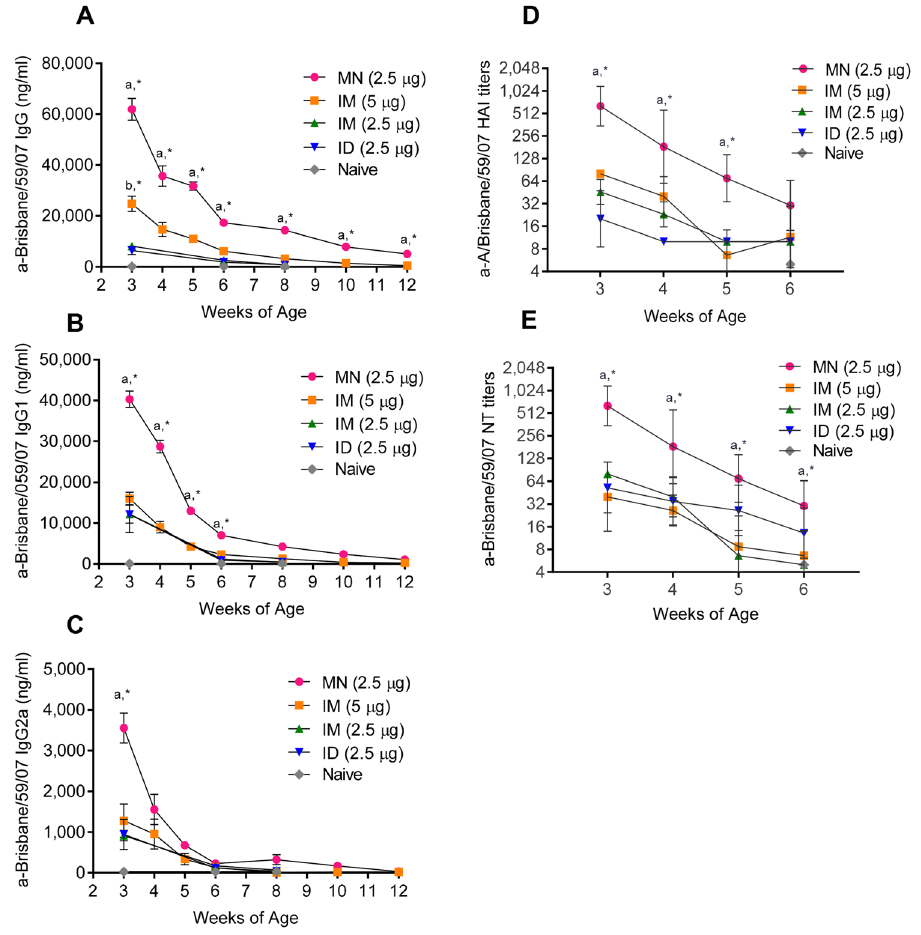
Figure 4. Humoral immune responses in pups born to mothers immunized during pregnancy. Anti-influenza binding antibodies were determined by ELISA in sera collected from pups at weeks 3 to 12 after birth. ( A ) IgG, ( B ) IgG1 and ( C ) IgG2a antibody titers [MN (2.5 ug), n = 10; IM (5 µ g), n = 10; IM (2.5 µ g), n = 5; ID (2.5 µ g), n = 5; Naïve, n = 5]. Values are expressed as mean ± SEM. ( D ) Hemagglutination inhibition (HAI) and ( E ) neutralizing antibody (NT) titers in sera collected 3, 4, 5, and 6 weeks after birth (n = 5 per group). HAI and NT values are expressed as geometric mean with ± 95% confidence interval. a [MN vs IM (5 μ g), IM (2.5 μ g), ID (2.5 μ g)]. b [IM(5 μ g) vs IM (2.5 μ g), ID (2.5 μ g)]. * p < 0.05. Statistical significance was determined using the Bonferroni-Dunn method, with alpha =